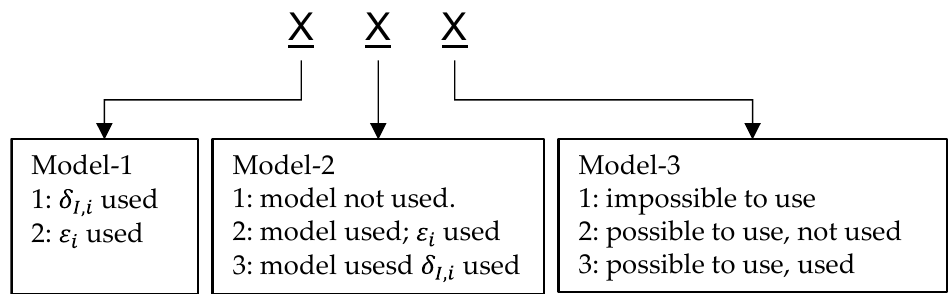
Figure 9. Explanation of version numbers.